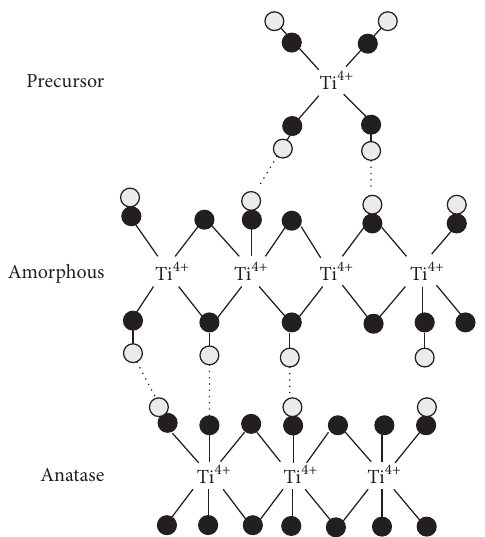
Figure 4: Titanium-oxygen (Ti-O) lattice